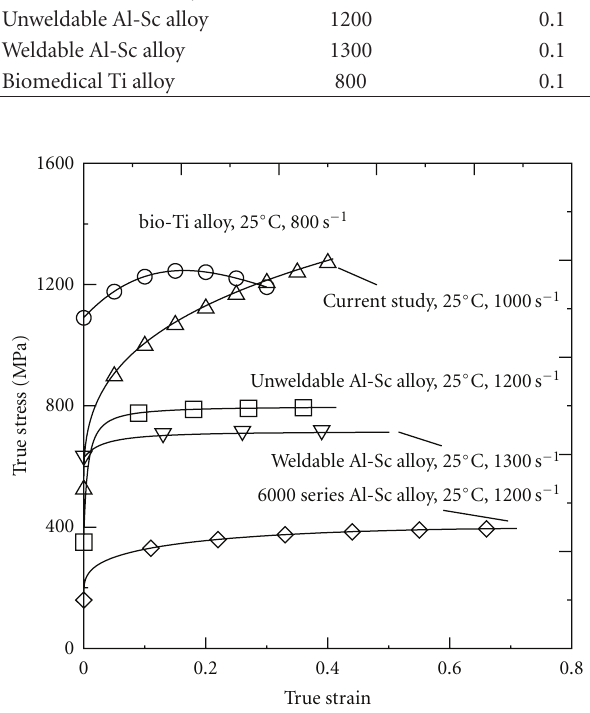
Figure 3: Comparison of stress-strain response of 316L stainless steel with that of biomedical Ti alloy, unweldable Al-Sc alloy, weldable Al-Sc alloy, and Al-Sc alloy,